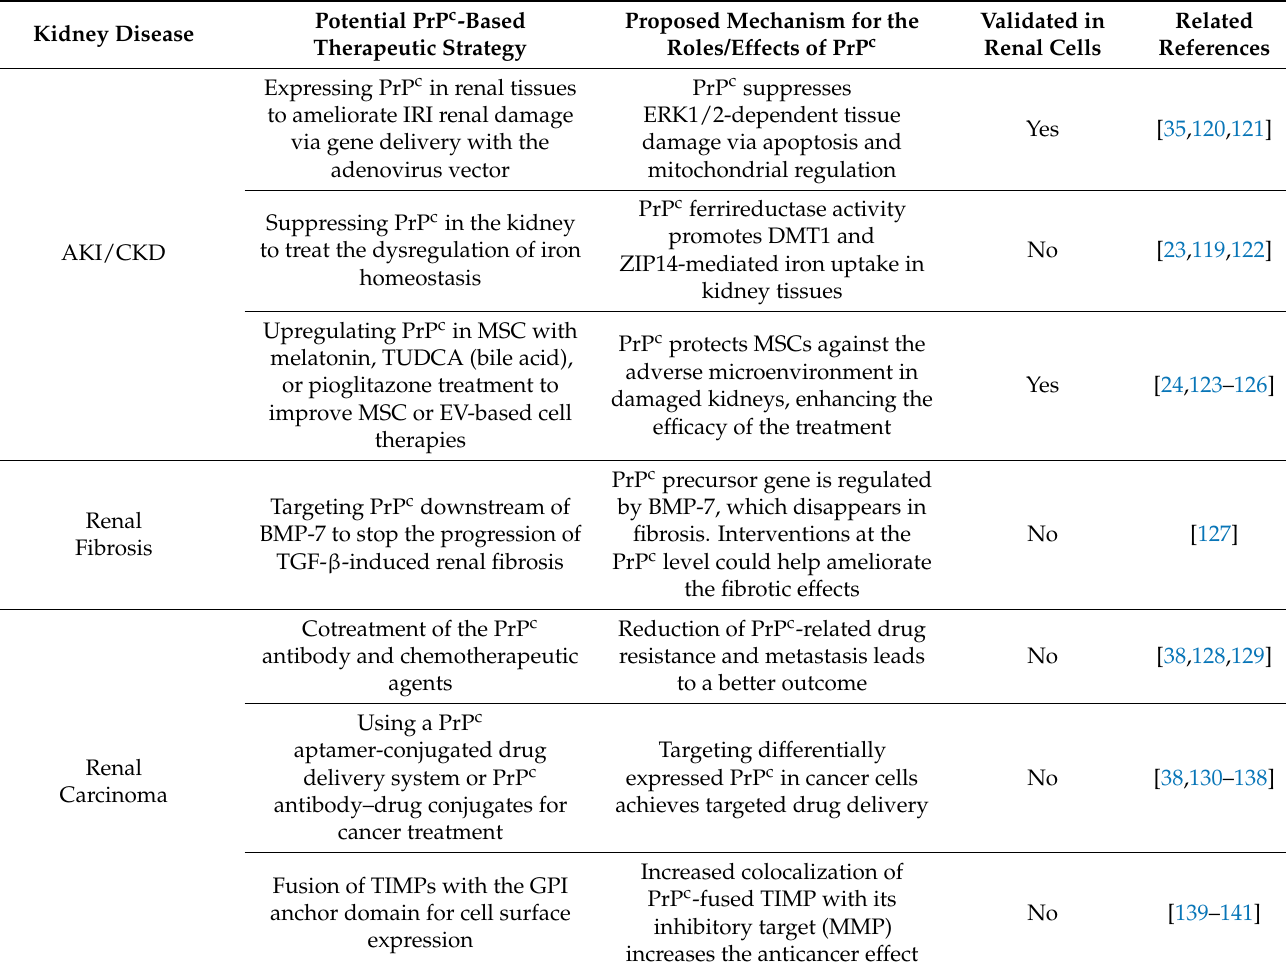
Table 1. Applications of the PrP c functions in designing therapeutic strategies for renal diseases. Potential PrP c -Based Kidney Disease Therapeutic